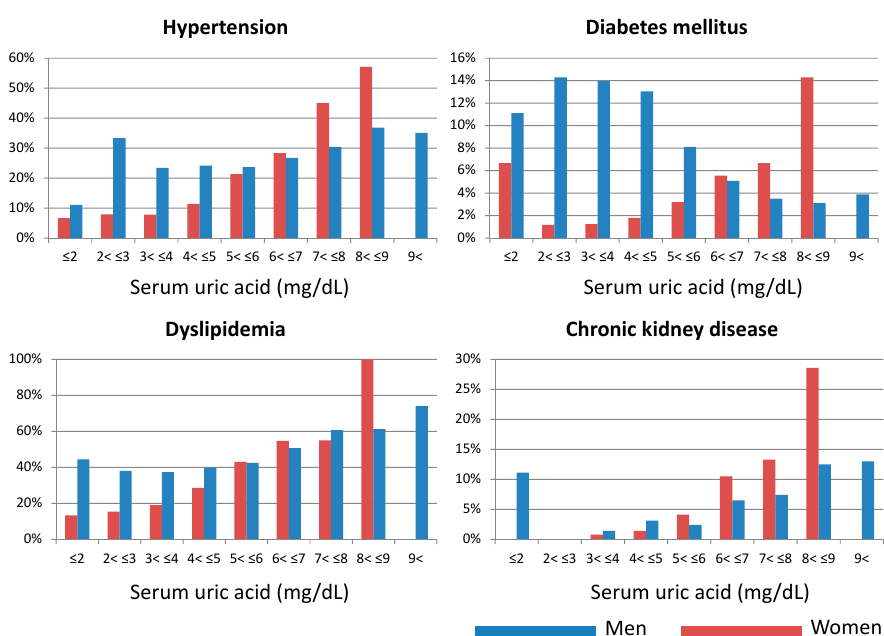
Figure 2. Prevalence of hypertension, diabetes, dyslipidemia, and chronic kidney disease in each serum urate at baseline (2004). Blue bars showed men and red bars showed